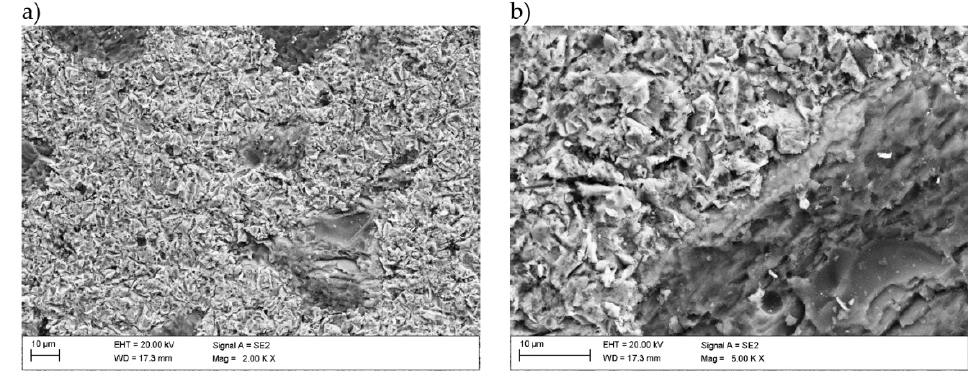
Figure 13. SEM micrographs of craters received after erosion test with impingement angle 90°, magnification ( a ) 2000x, ( b ) 5000x.